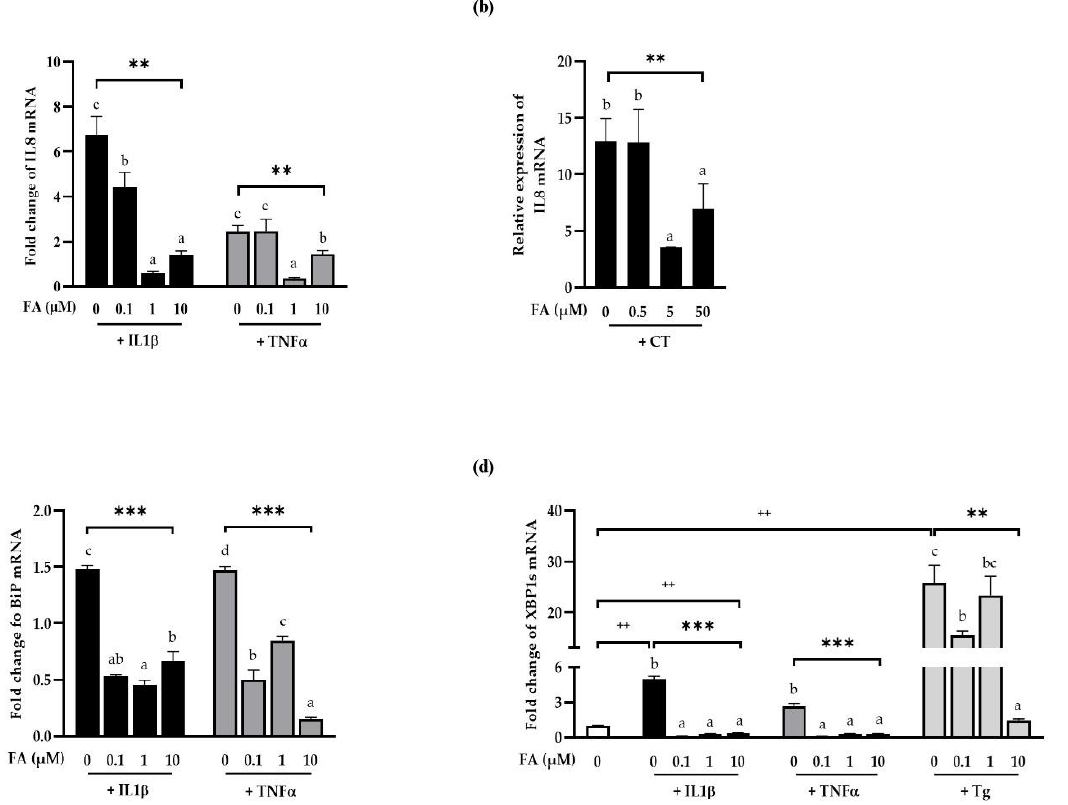
Figure 3. Inhibitory effect of ferulic acid on ER stress and proinflammatory response in polarized human intestinal epithelial cells. Polarized human intestinal epithelial cells (( a , c , d ) T84 cells, ( b ) Caco-2 cells) were pretreated with the indicated concentrations of FA for 24 h and then treated with either 0.1 μg/mL IL1β only, 100 ng/mL TNFα only , or cytokine cocktail (50 ng/mL human TNFα+ 50